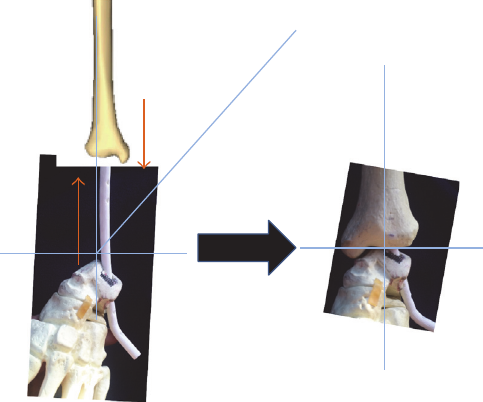
Figure 2: Varus angulation of 45 degrees required for nail